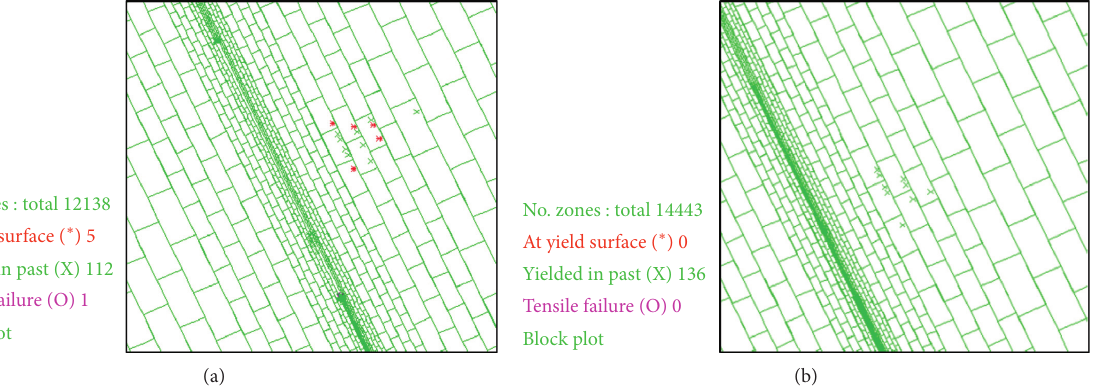
Figure 17: Surrounding rock failure pattern with 160m stope height. (a) Caving. (b) Backfilling.